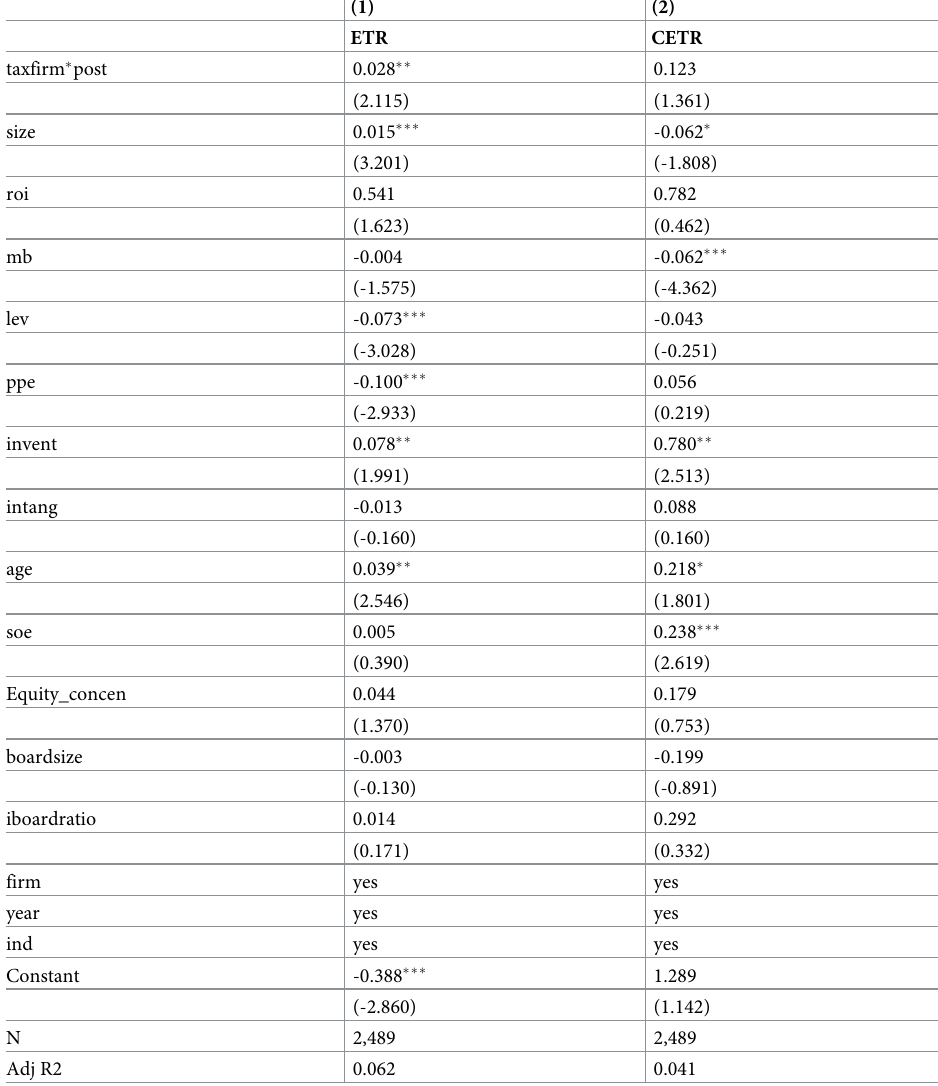
Table 9. Effect of tax-related comment letter on ETR and cash